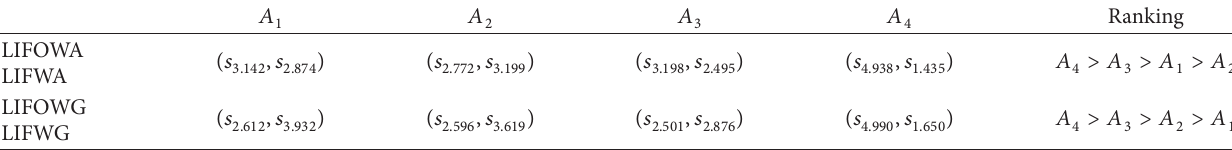
Table 6: The collective overall preference values and the rankings of